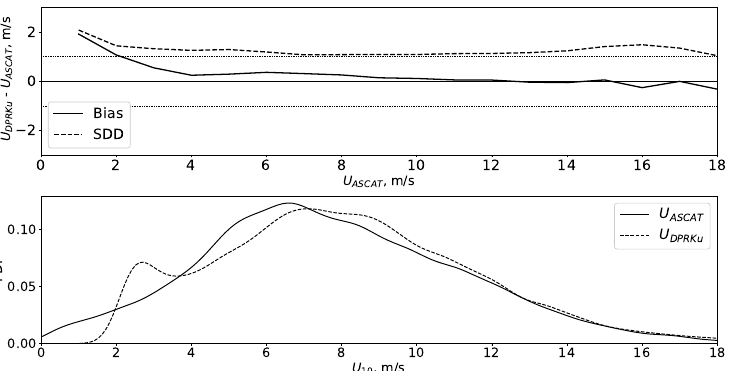
Figure 8. Wind speed difference (bias) and standard deviation of the difference (SDD) between DPR Ku-band radar and ASCAT ( top ). Wind speed PDF for DPR and ASCAT validation array ( bottom ). The performance of the algorithm was evaluated for different parts of the swath, corresponding to the footprints of beams with incidence angles 0 ◦ , 2 ◦ , 4 ◦ , 6 ◦ , 8 ◦ and 10 ◦